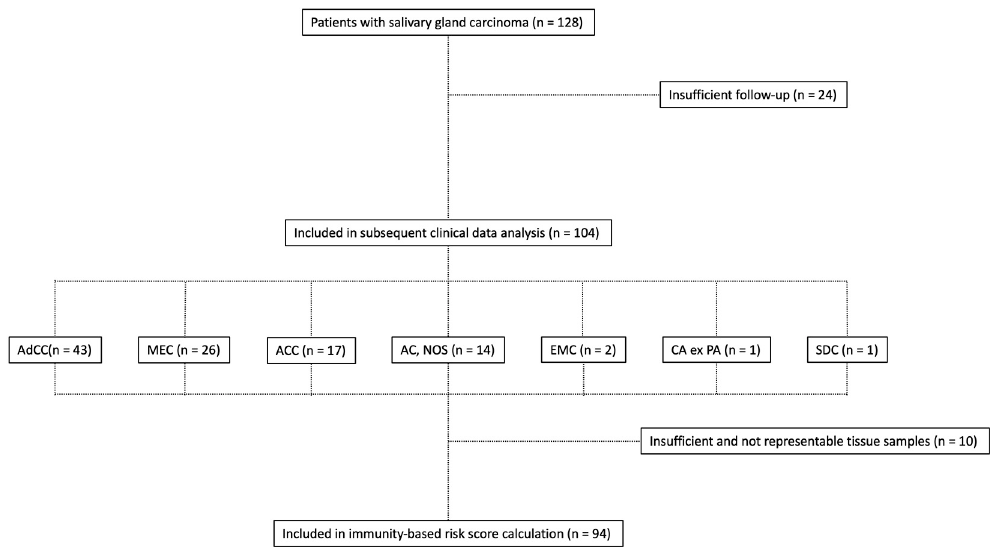
Figure 1. Flowchart depicting the composition of the study group.